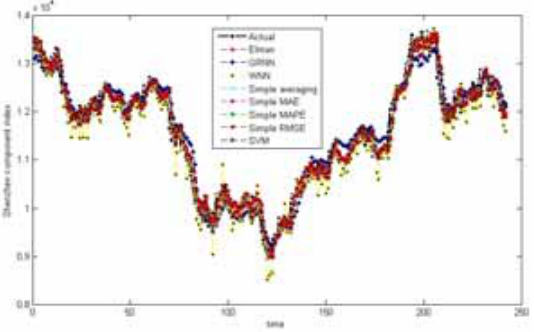
Fig. 3. The prediction of the daily stock index data of Shenzhen component index using three single base models, four linear ensemble methods, and the proposed non-linear ensemble model.